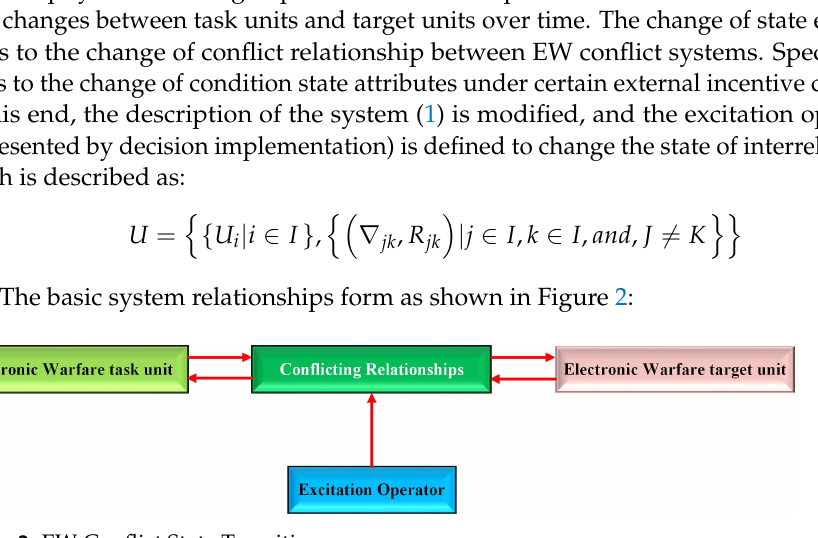
Figure 2. EW Conflict State